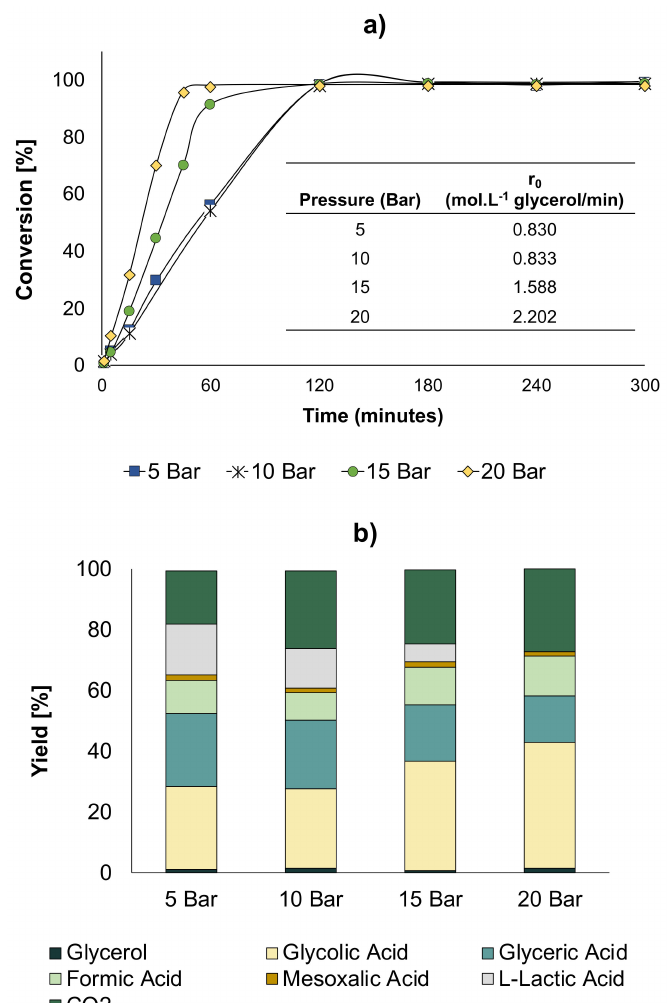
Figure 10. Production of glycolic acid at different O 2 pressures under optimal conditions determined in the previous experiments: ( a ) conversion of glycerol and initial reaction rates, and ( b ) product